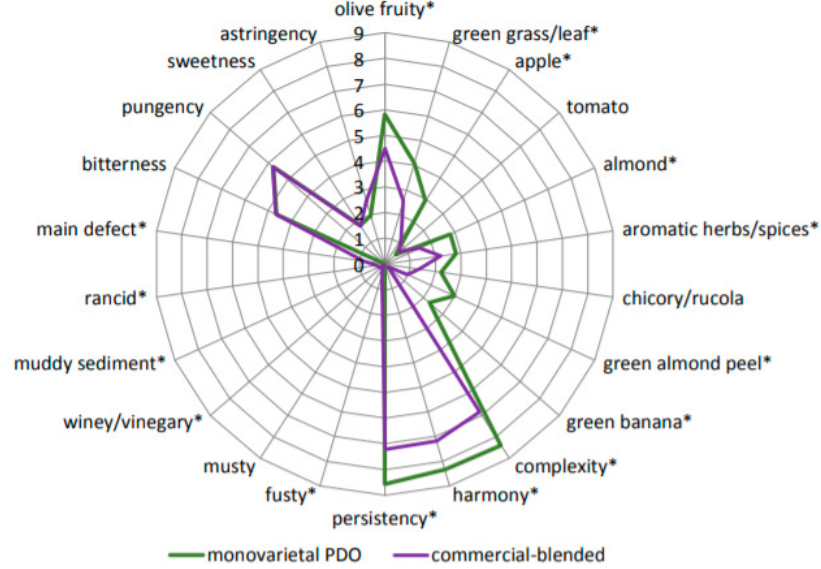
Figure 1. Spiderweb diagram with statistical significance differences indicated by (*) asterisk for each sensory attribute and defect.